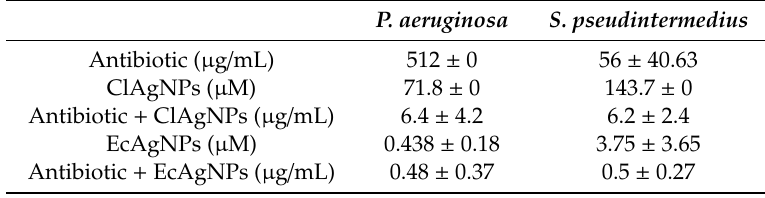
Table 1. Determination of MIC values for ClAgNPs and EcAgNPs alone and in combination with